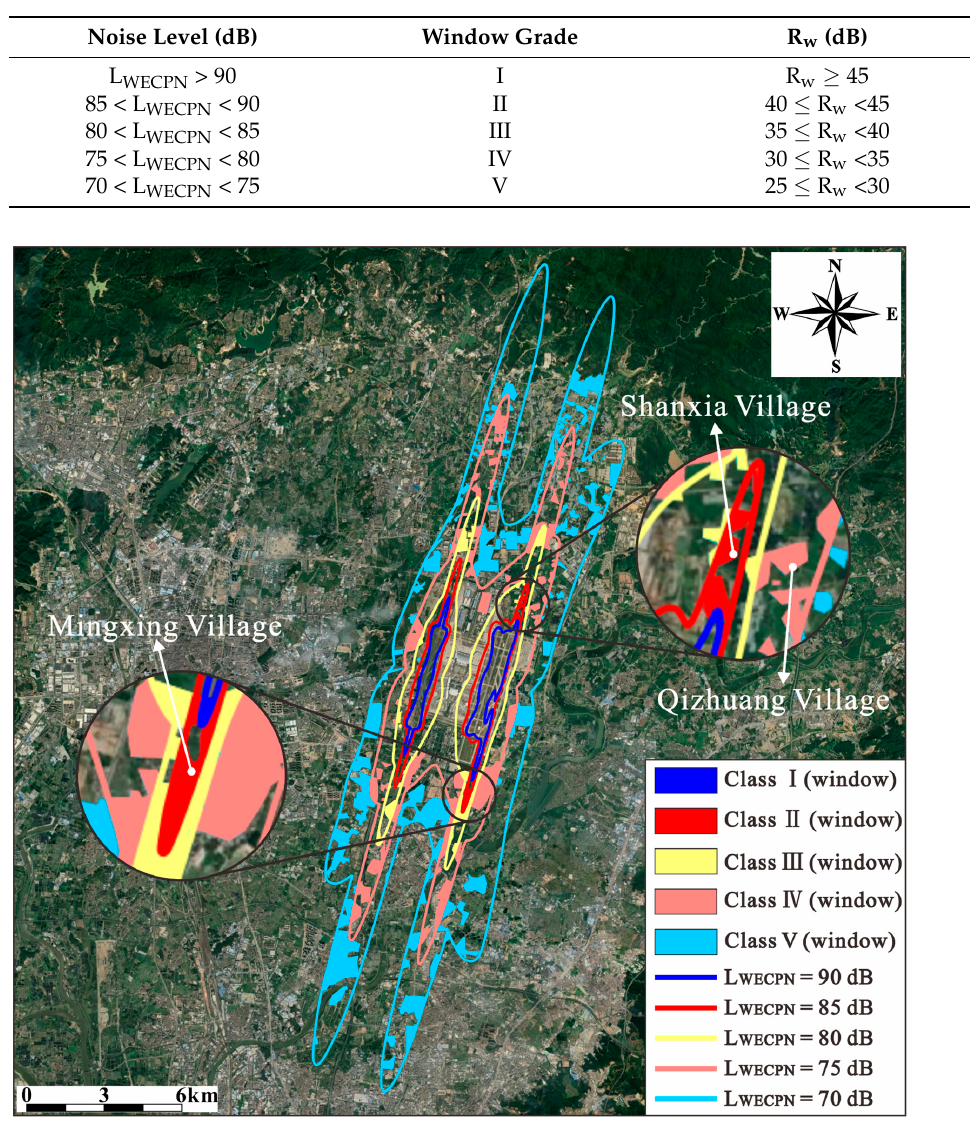
Figure 14. Areas around BIA where different grades of sound insulation windows are required.